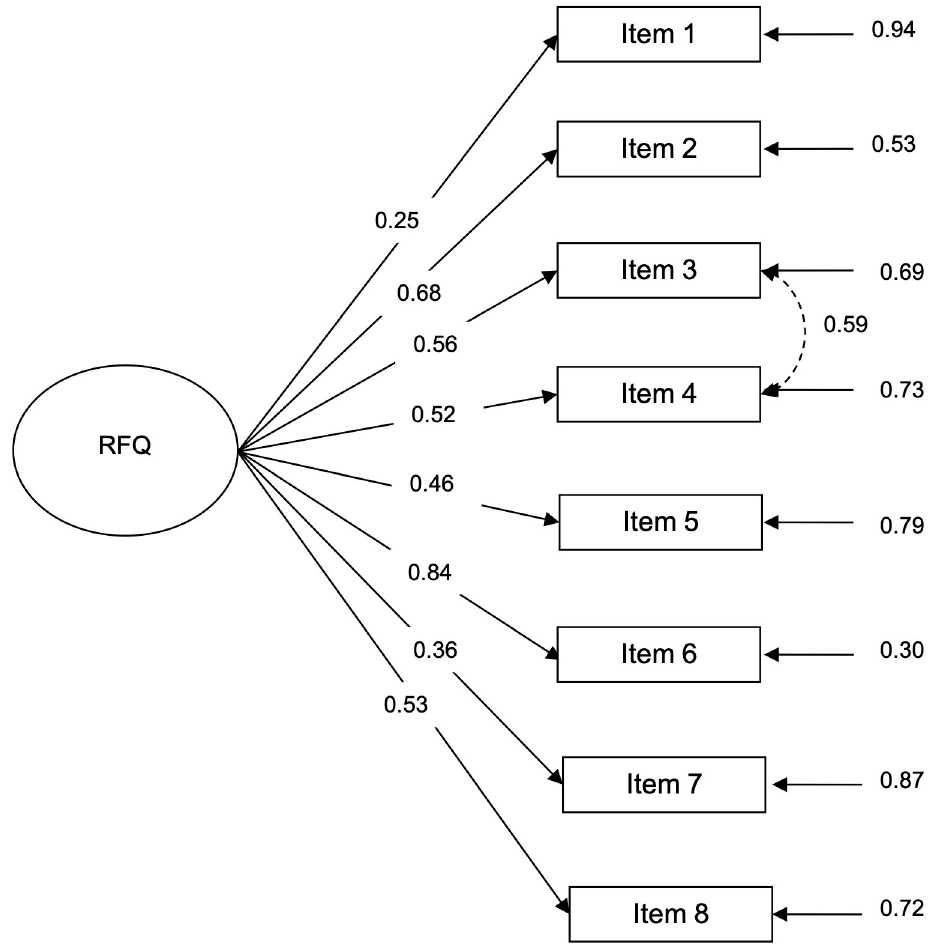
Fig 1. Confirmatory factor analysis for the one-factor structure in the non-clinical sample. Note: The standardized factor loadings and error variances are shown. As in Spitzer et al. [28], Mu¨ller et al. [29], and Wozniak-Prus et al. [38] studies, the error of items 3 and 4 were allowed to